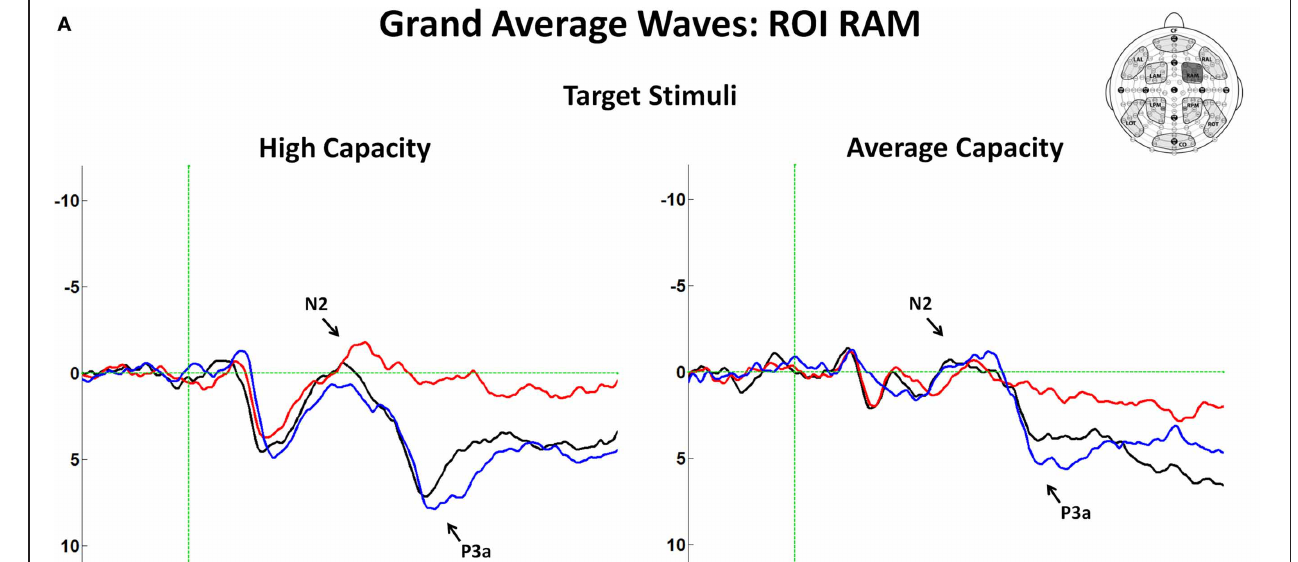
ERP responses at the centro-posterior ROI, RPM in response to target stimuli for high capacity and average capacity subjects. Arrows illustrate the P3b